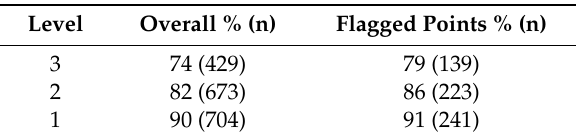
Table 1. LC percent agreement at di ff erent levels for all points and points flagged as potential high-quality.